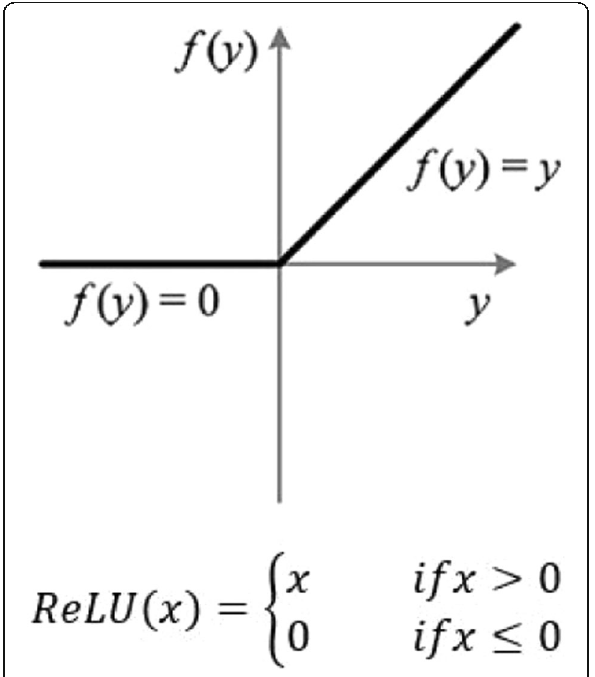
Fig. 3 ReLU function expression and image